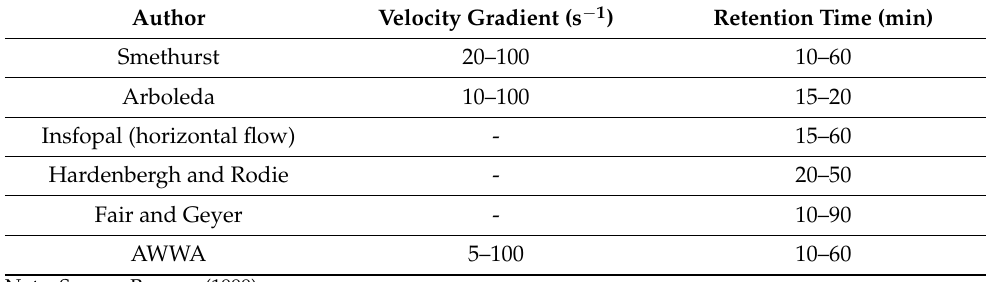
Table 4. Recommended retention time ranges for conventional hydraulic flocculators.